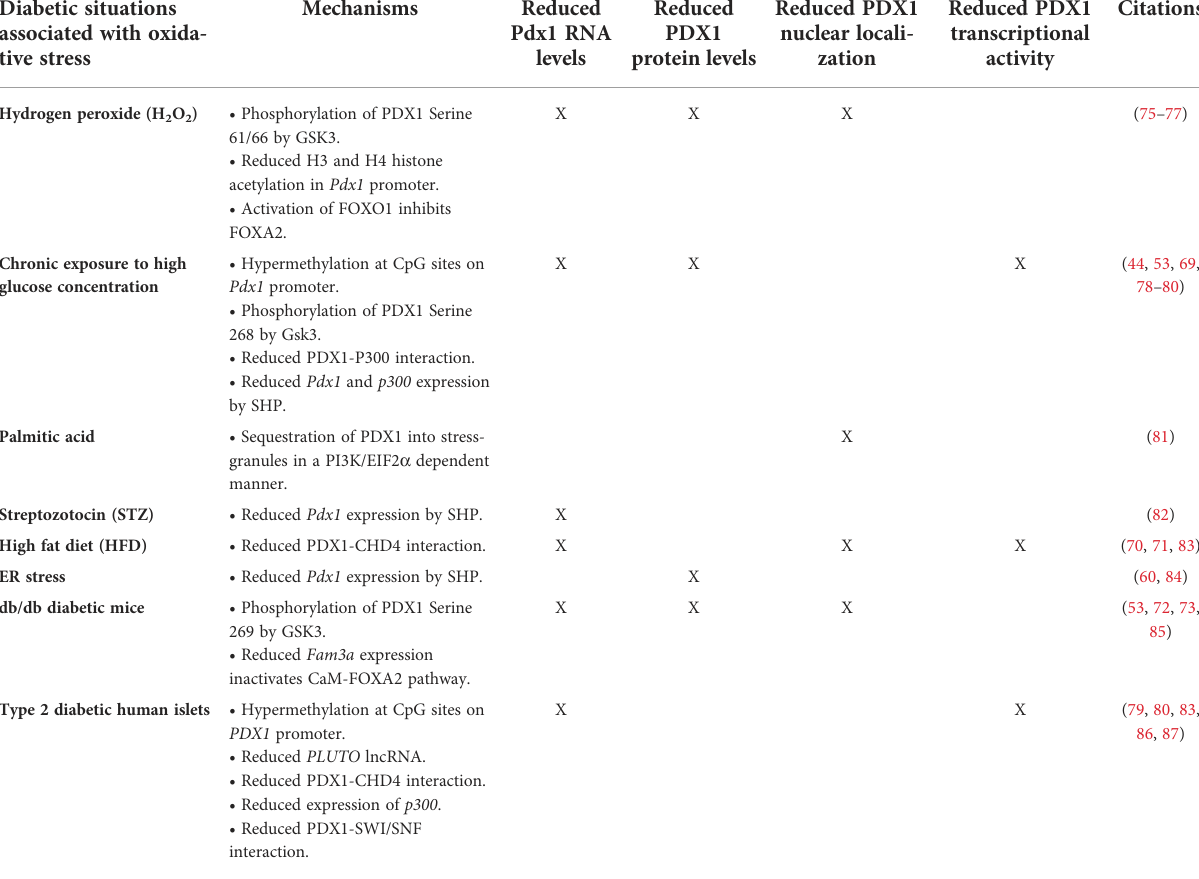
TABLE 1 Ros-dependent mechanisms that reduce Pdx1 levels and activity during diabetes. Diabetic situations associated with oxida- tive